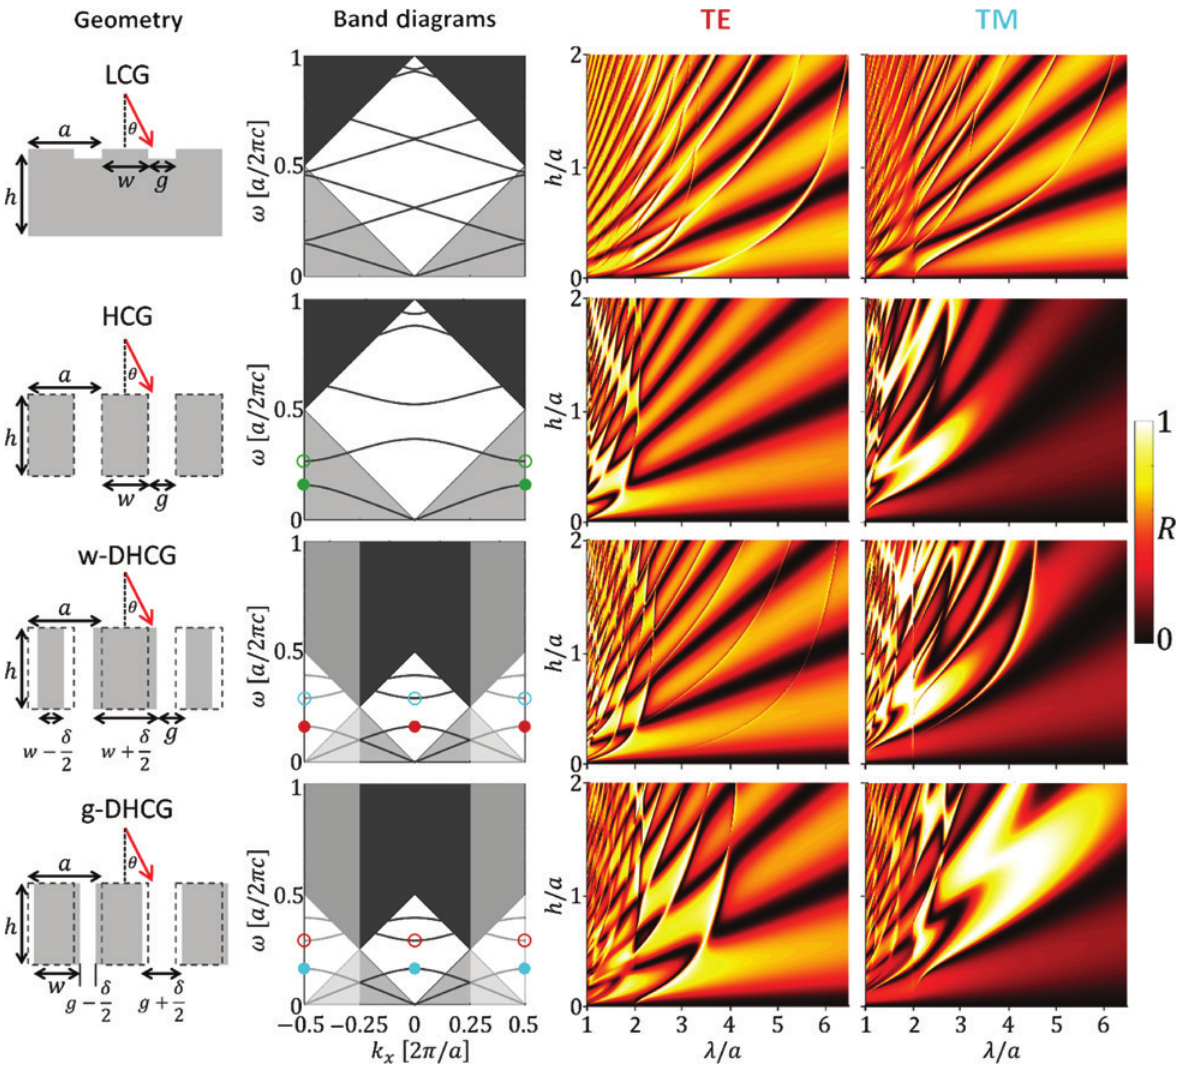
Figure 1: Comparison of four subwavelength gratings. Rows 1–4 depict the physics of, respectively, LCGs, unperturbed HCGs, width-perturbed dimerized HCGs (w-DHCGs), and gap-perturbed dimerized HCGs (g-DHCGs). Columns 1–4 depict, respectively, the typical geometry, band diagrams for h = ∞ calculated by a 1D plane-wave expansion method (where the white diamond represents the 0th-order domain), and spectral reflectance maps (calculated by rigorous coupled-wave analysis) with TE and TM incidence for different aspect ratios, h / a . LCGs can be seen to have very pointed bands near k sin( θ ) = 0 while having sharp spectral lines throughout the reflectance maps. HCGs have flat bands but primarily exhibit broad spectral features. DHCGs have flat bands but consistent sharp spectral features. Brillouin zone folding occurs upon doubling the period of a HCG, folding modes at the edge of the first Brillouin Zone (FBZ) (marked by closed and open circles for bonding and anti-bonding modes, respec- tively) onto the center of the FBZ in DHCGs. The band shapes are retained, but the modes are now accessible to free-space excitation with a coupling strength controlled by the magnitude of the perturbation. TE light excites the modes marked as red, and TM light excites modes marked as light